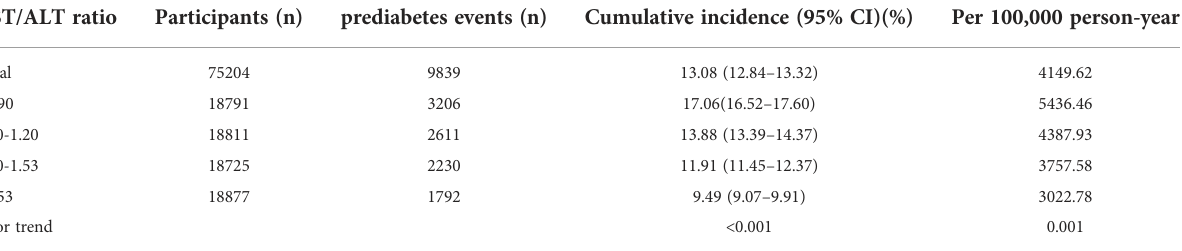
TABLE 2 Incidence rate of incident prediabetes.